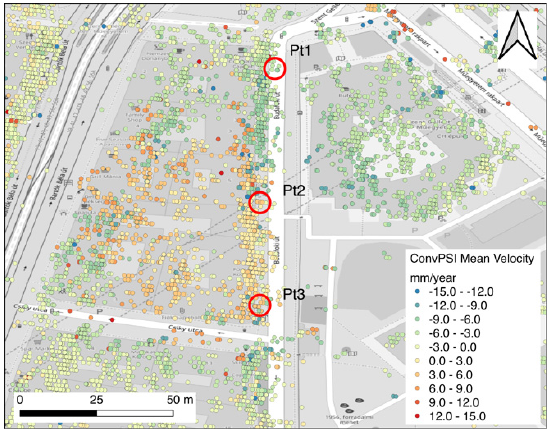
Figure 10. The distribution of the resulting points of PSI around Szent Gellért Station. The color of the points represents the mean velocity of ConvPSI. Pt1, Pt2, and Pt3 are the selected points, and the time evolutions were investigated. The background map was obtained from OpenStreetMap (OSM).